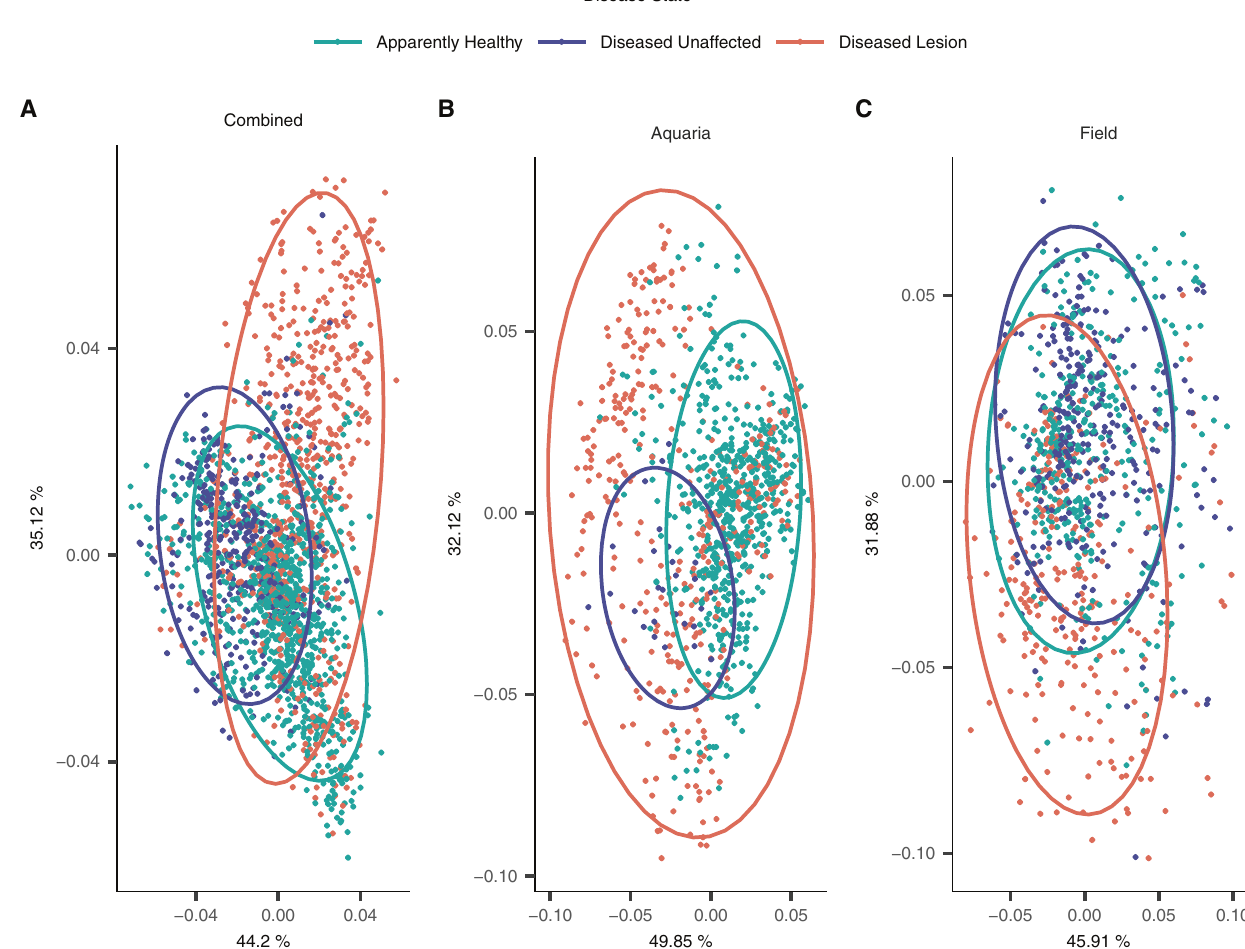
Fig. 4 Microbial differences in coral disease state among apparently healthy colonies (AH), and unaffected (DU) and lesion (DL) areas on diseased colonies in beta-diversity using a robust Aitchison Distance. A both aquaria and fi eld samples ( “ Combined ” ), and B aquaria and C fi eld samples only. Samples from Acropora spp. were excluded and the three coral compartments (mucus, tissue slurry, and tissue slurry skeleton) were included in this analysis. The ellipses represent the center of the Euclidean distance from the respective disease state with a 95% con fi dence of the